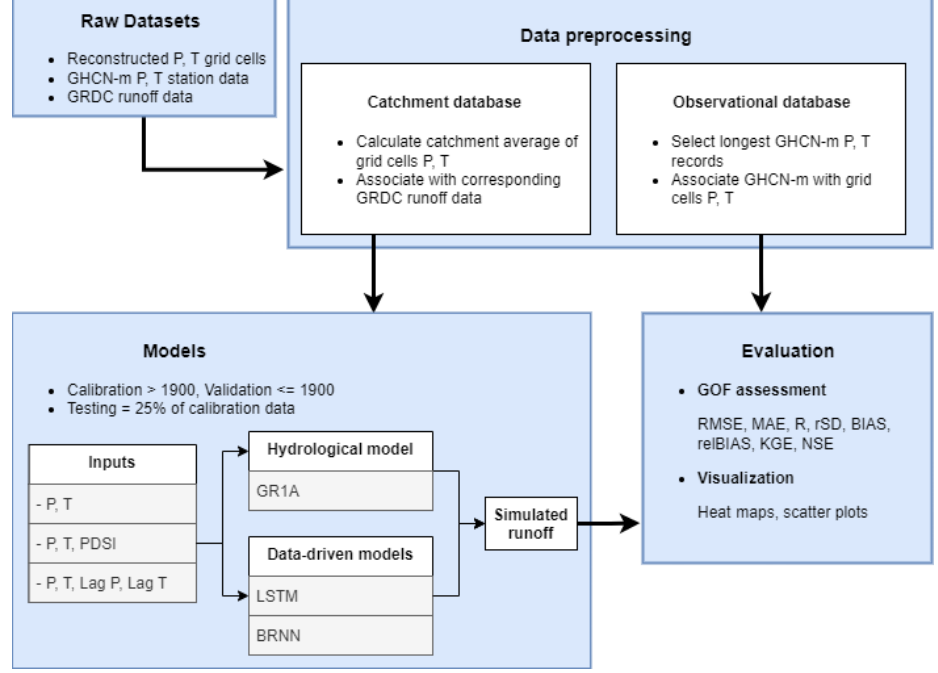
Figure 2. A schematic representation of workflow carried out in the